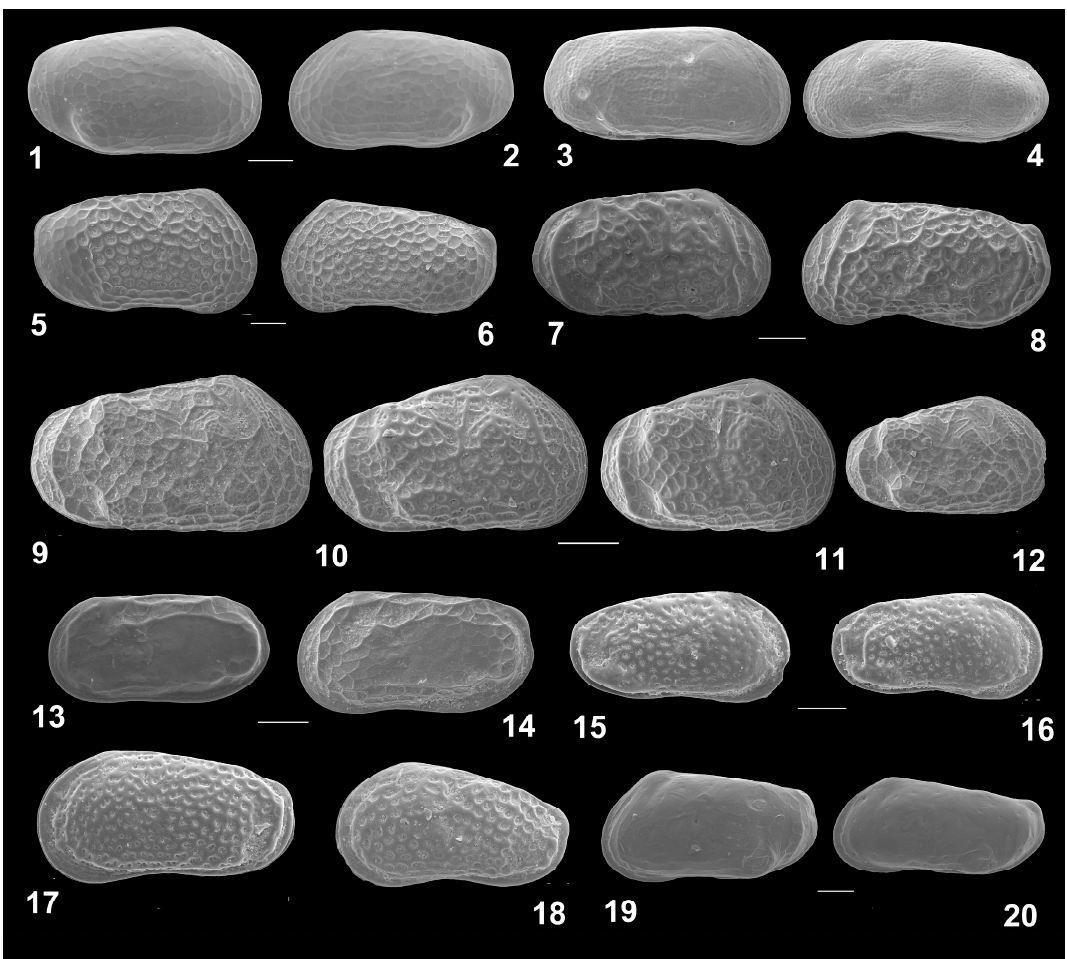
Figure 8. Ostracods of the studied Rybachya core. RV, right valve; LV, left valve; f, female; m, male; Ad, adult stages; juv, juvenile stages. Scale bar 100 µm. (1)–(2) Amnicythere pirsagatica (Livental in Agalarova et al., 1940), RVf and LVf; (3)–(4) Amnicythere reticulata (Schornikov, 1966), RVf and LVm; (5)–(6) Amnicythere martha (Livental in Agalarova et al., 1940), RVf и LVm; (7)–(12) Euxinocythere bosqueti , RVf and LVm, RVjv (9–12); (13)–(14) Amnicythere caspia (Livental, 1938), LVm and LVf; (15)–(18) Euxinocythere relicta (Schornikov, 1964), RVf, RVf, LVf, LVA–1; (19)–(20) Amnicythere longa , LVf and LVm.